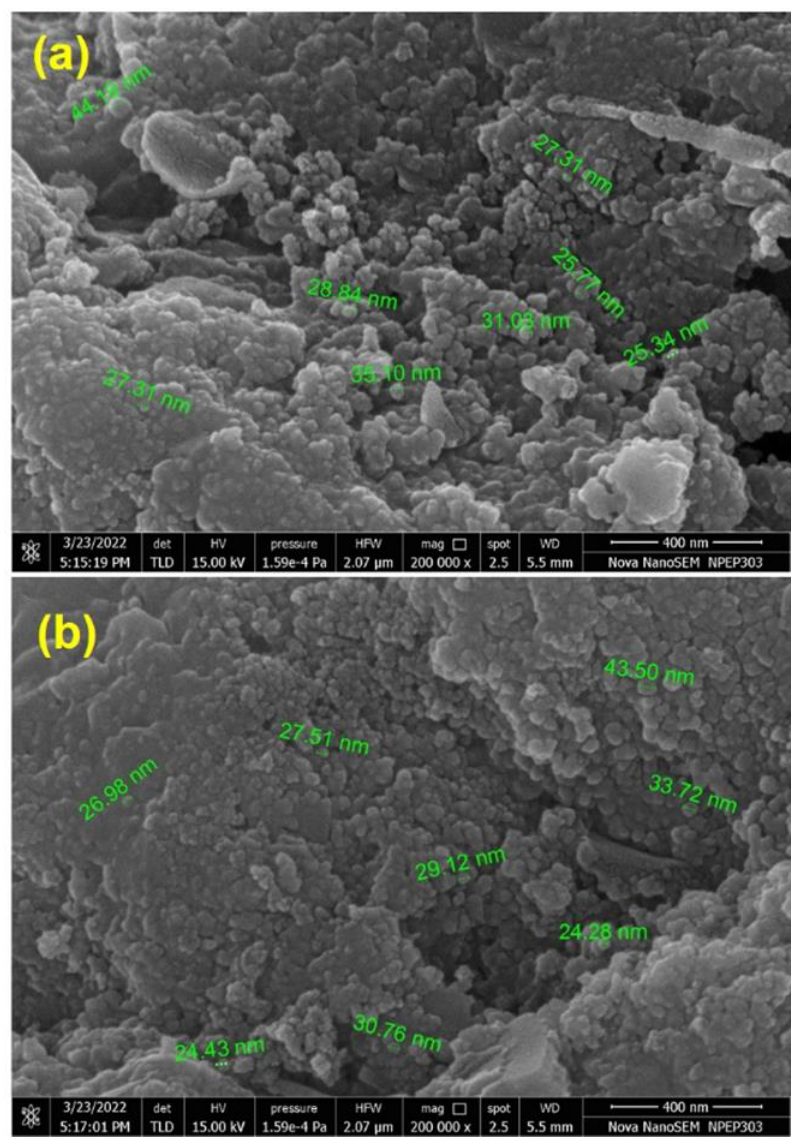
Figure 2. FESEM images for Cu 2 WS 4 in different region.